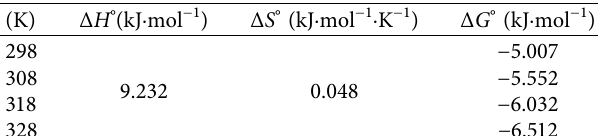
Figure 15: Illustration of RBB dye interaction with RDP adsorbent. Table 5: Thermodynamic parameters of RBB adsorption onto the RDP.